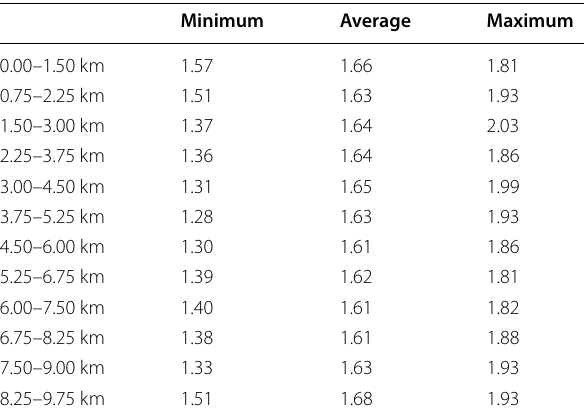
Table 1 Minimum, average, and maximum V in different depth ranges